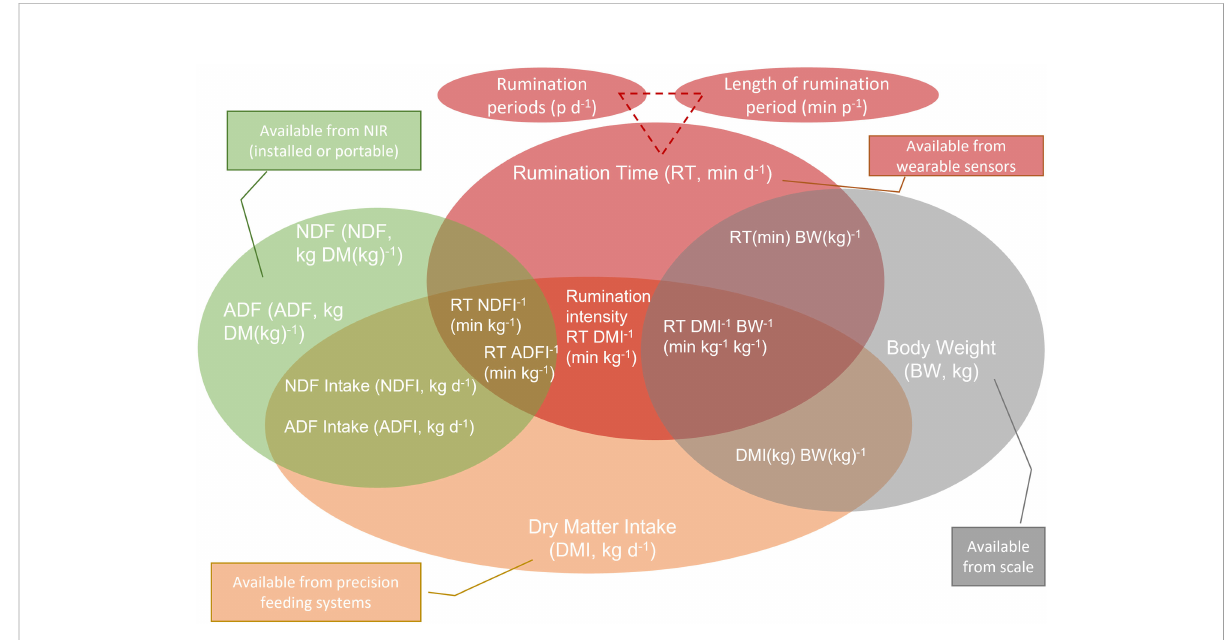
FIGURE 1 A picture of rumination-derived data available from digital on-farm